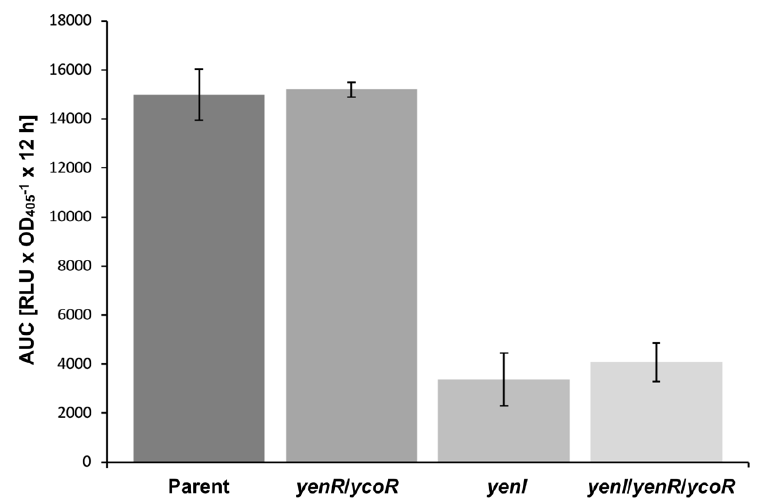
Figure 5. Expression of spyA over 12 h in the parent and QS mutants at 37 °C. The expression of the P spyA :: luxCDABE promotor fusion was comparable for the parent and yenR / ycoR mutant but was reduced ~4-fold in the yenI and yenI / yenR / ycoR mutants.